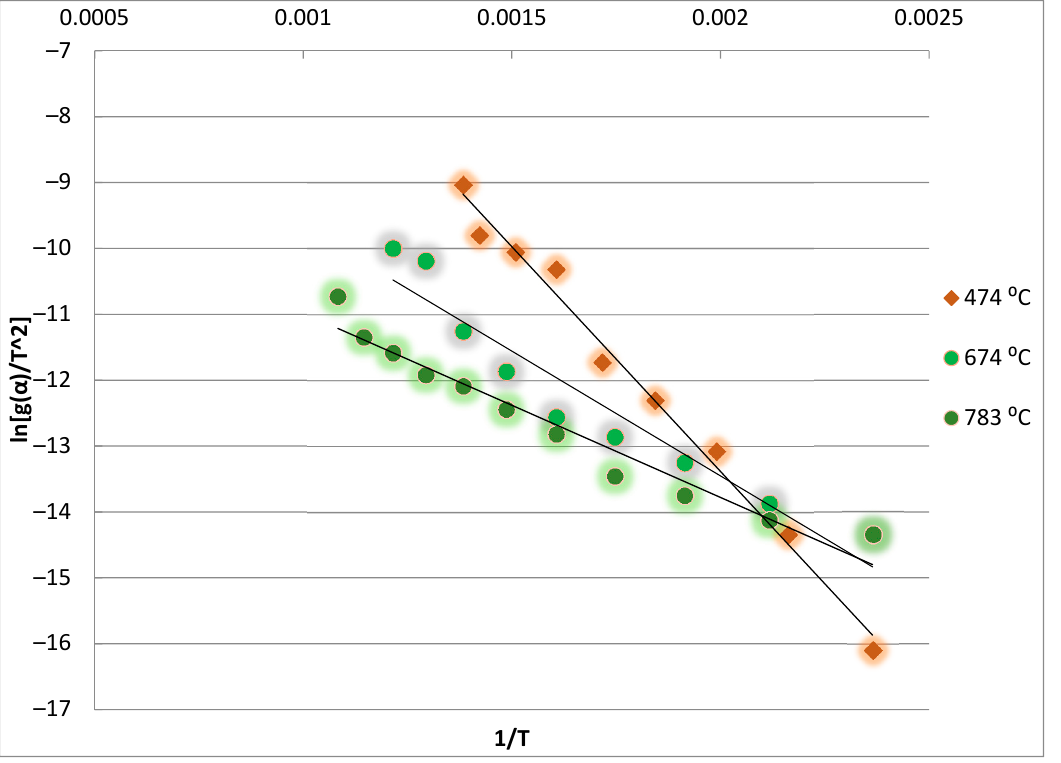
Figure 2. Effect of pyrolysis temperature on the kinetic parameters.